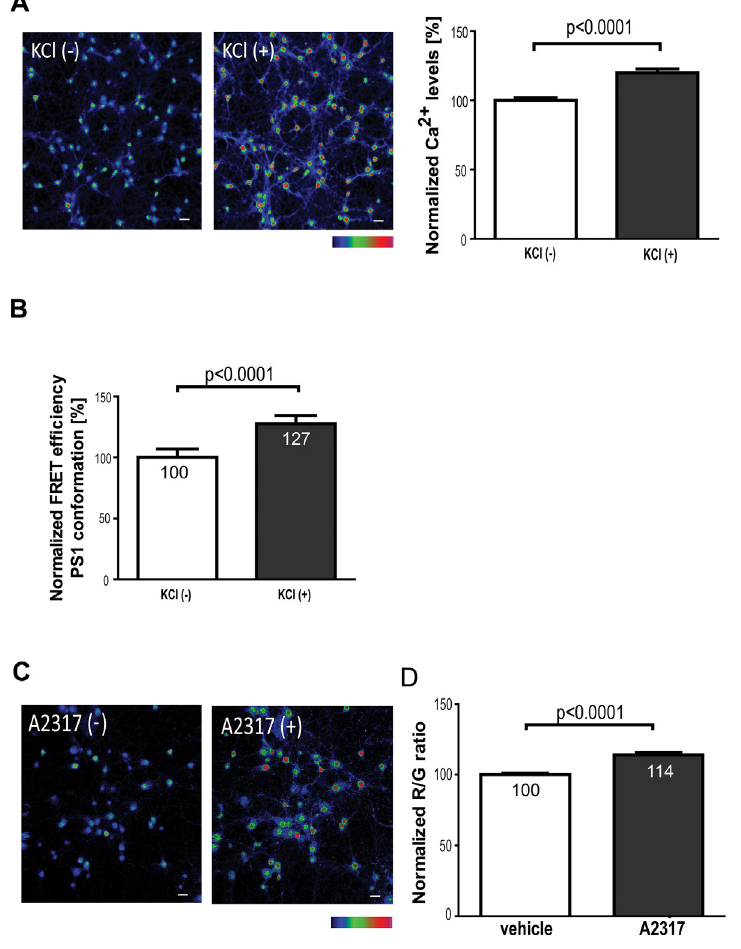
Figure 5. Ca 2+ overload triggers conformational change of PS1. (A) Increase in the in- tracellular calcium levels in neurons treated with 50 mmol/L KCl is monitored by Oregon Green BAPTA-1/AM (images) or by Indo-1 ratiometric probe (graph). The pseudo-col- ored images show intracellular calcium levels pre- and post-treatment. The red pixels correspond to higher calcium levels. The graph presents quantification of the intracel- lular calcium levels. n = 310 (KCl–) n = 251 (KCl+), n = total number of neurons analyzed from three independent experiments mean ± SEM, two-tailed unpaired Student t test. The scale bar corresponds to 20 μ m. (B) FLIM analysis of the PS1 conformation pre- and post-KCl treatment in neurons. Increase in the FRET efficiency, reflective of pathogenic “closed” PS1 conformation, is detected after 15 min of KCl treatment. n = 84 (KCl–) n = 85 (KCl+), n = total number of neurons analyzed from 3 independent experiments, mean ± SEM, two-tailed unpaired Student t test. The data are normalized to the values recorded in the neurons in KCl– conditions. (C) Increase in the intracellular calcium levels in neurons treated with 5 μ mol/L A2317 calcium ionophore monitored by Oregon Green BAPTA-1/AM. The pseudo-colored images show intracellular calcium levels pre- and post-treatment. The red pixels correspond to higher calcium levels. The scale bar corresponds to 20 μ m. (D) Spectral FRET analysis of the PS1 conformation pre- and post-A2317 calcium iono- phore treatment in primary neurons. Increase in FRET efficiency (R/G ratio) reflective of pathogenic “closed” PS1 conformation is detected in A2317-treated neurons. n = 180 (vehicle) n = 185 (A2317), n = total number of neurons analyzed from three independent experiments, mean ± SEM, two-tailed unpaired Student t test. A β – amyloid β ; PS1 – presenilin 1; FRET – Förster resonance energy